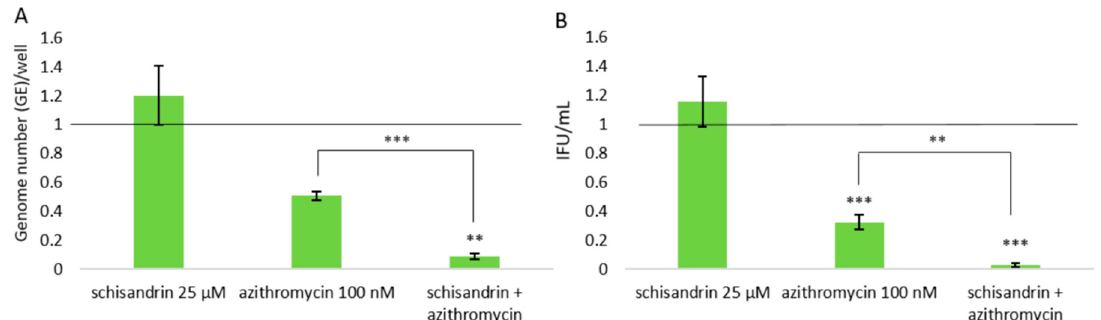
Figure 3. Impact of the concomitant administration of schisandrin (25 µM) and azithromycin (100 nM) on C. pneumoniae genome numbers ( A ) and EB progeny production ( B ). Data are normalized on the non-treated infection control and shown as a mean ± SEM (n ≥ 4) statistical significance is presented as marks of p -values: < 0.01: **; < 0.001: ***. Abbreviations: IFU = inclusion forming unit.